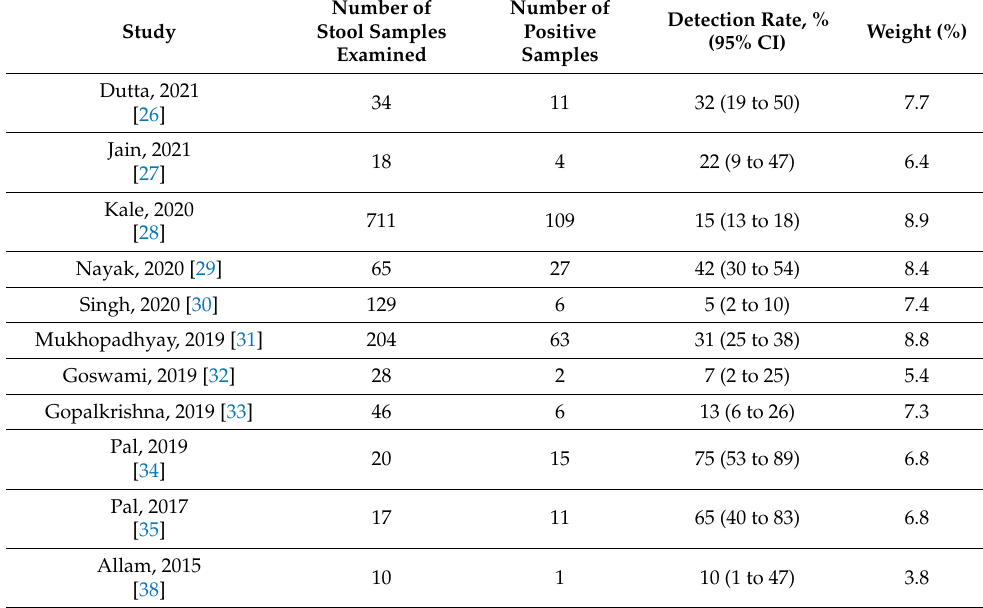
Table 1. Pooled prevalence of laboratory-confirmed cholera during outbreaks (India,